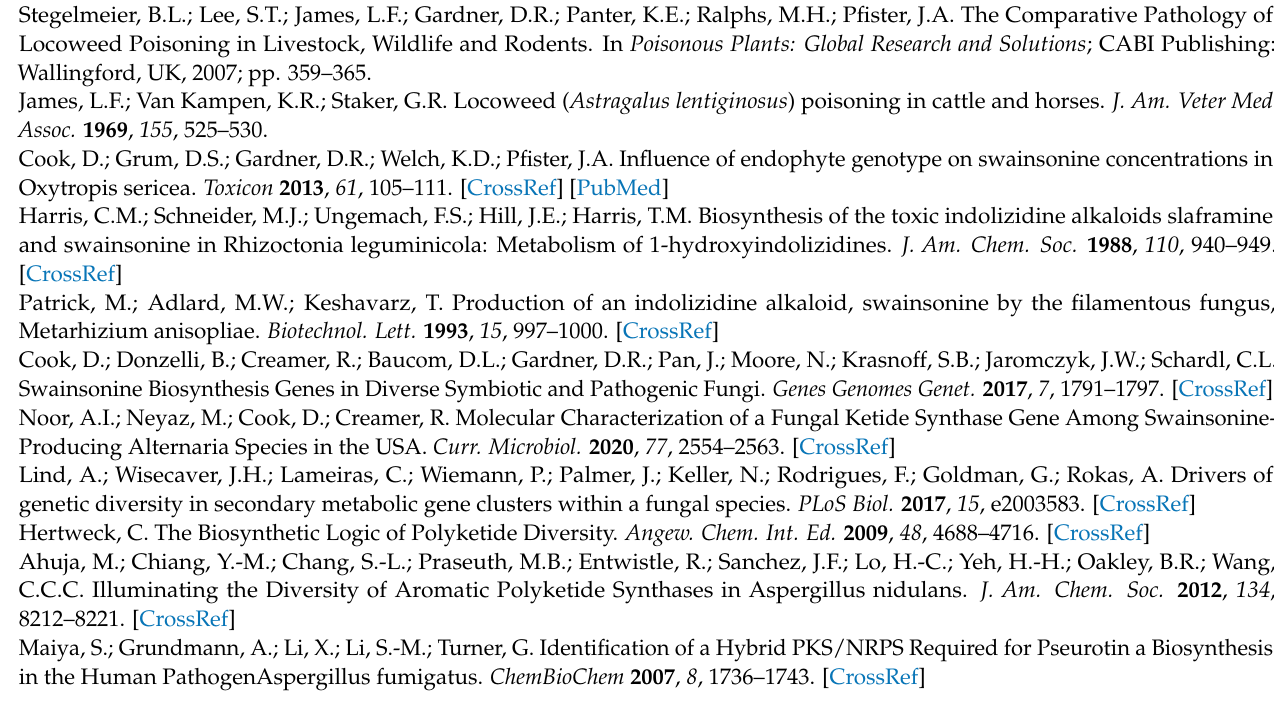
Figure S24: Maximum parsimony tree (MUSCLE alignment and 1000 replicates). Pyrenophora teres was used as the outgroup. Fungi in tree are pblast results of 5682 sequence.: Figure S25: Maximum parsimony tree (MUSCLE alignment and 1000 replicates). Aspergillus luchuensis was used as the outgroup. Fungi in tree are pblast results of 9132 sequence. Table S1: GenBank accession numbers and amino acid percent identity of blast results of 2122 sequence, Table S2: Genbank accession numbers and amino